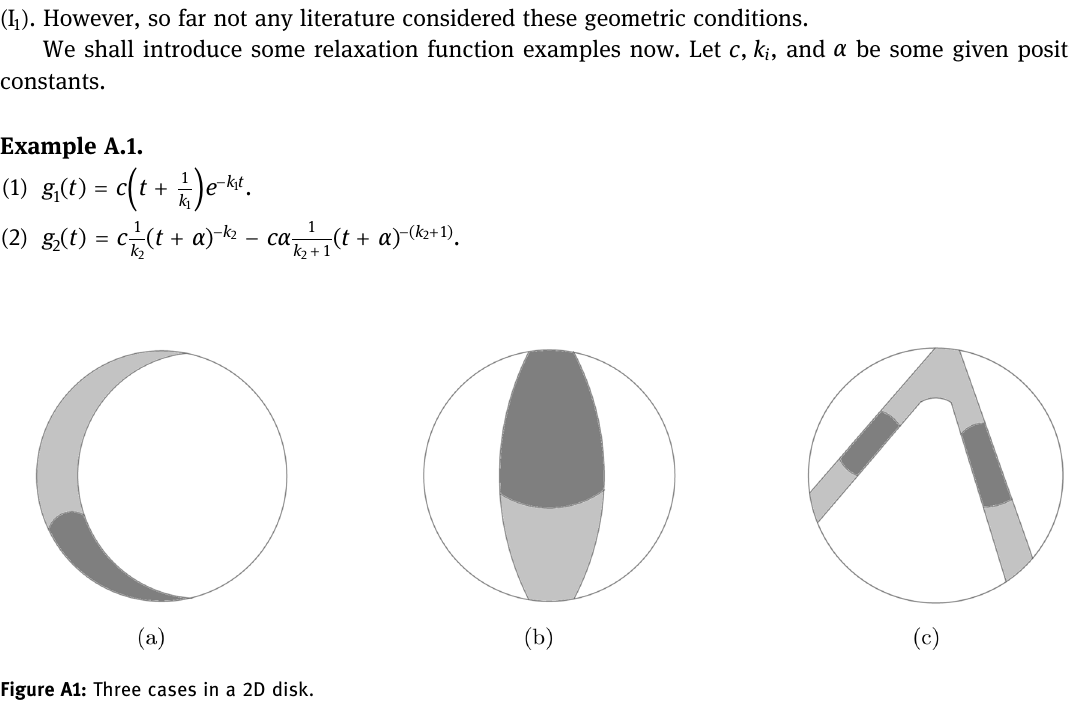
Figure A1: Three cases in a 2D disk.